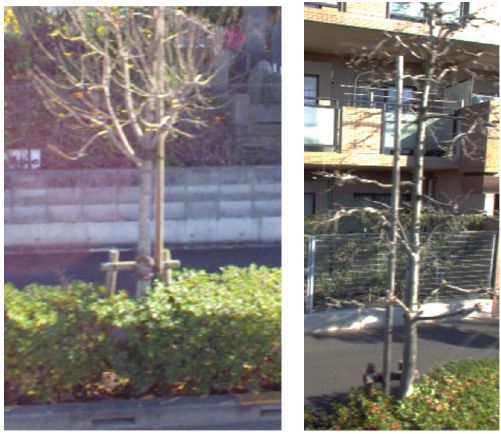
Figure 17 . Roadside trees with tree support precision and 95.1 percent of recall for 102 roadside